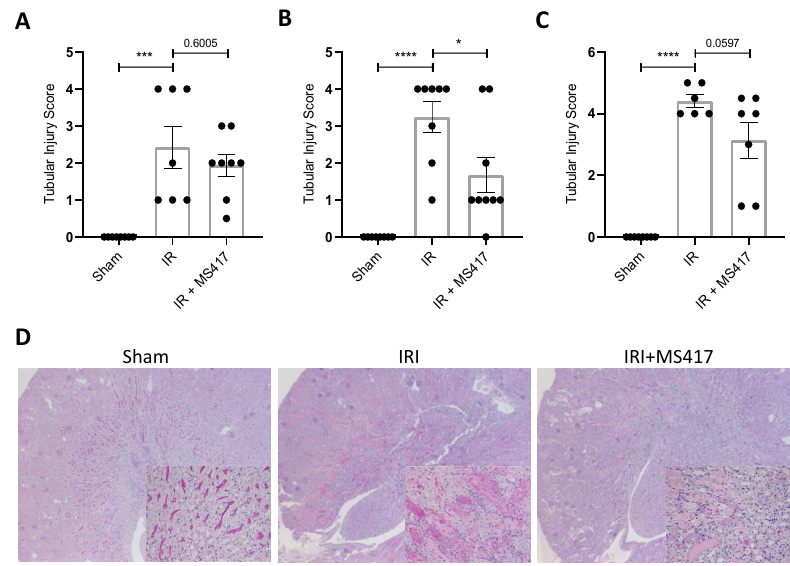
Figure 10. BRD4 inhibition attenuated tubular injury following IRI. ( A – C ) Semi-quantitative scoring of tubular injury on PAS sections performed in a blinded manner at 6 h ( A ), 24 h ( B ), and 48 h ( C ). ( D ) Representative images of PAS staining performed at 24 h in Sham, IRI and IRI + MS417 mice. Images are at 1.6× magnification with high magnification inserts at 20×. n = 7–9, * p < 0.05, *** p < 0.001, **** p < 0.0001.